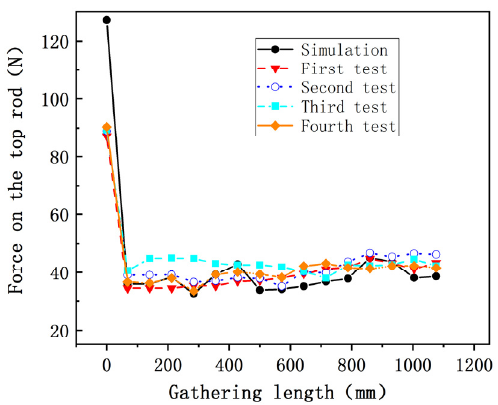
Figure 16. The comparison of finite element results and experimental data with the top rod load.